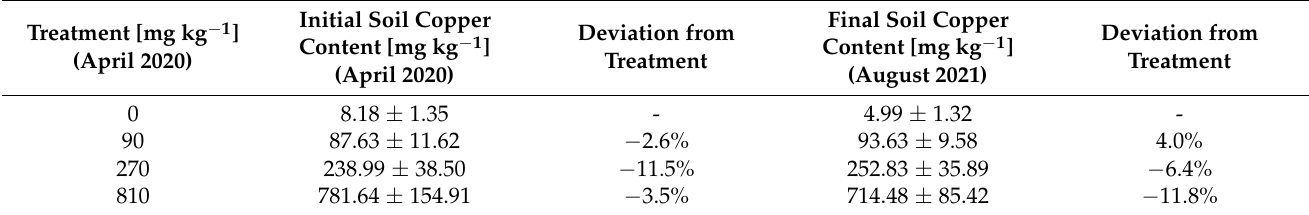
Table 4. Total copper found in the soil in mg kg − 1 in relation to the desired treatment. See Table S2 for the corresponding